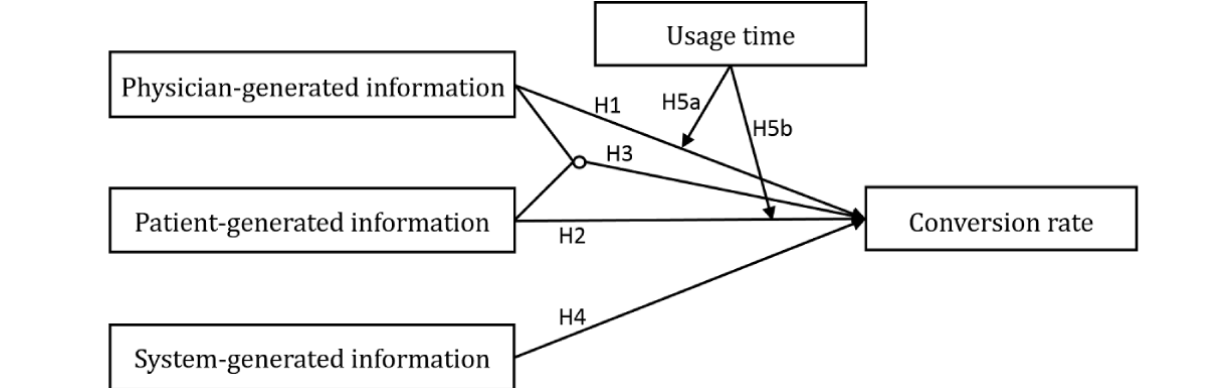
Figure 2. Research